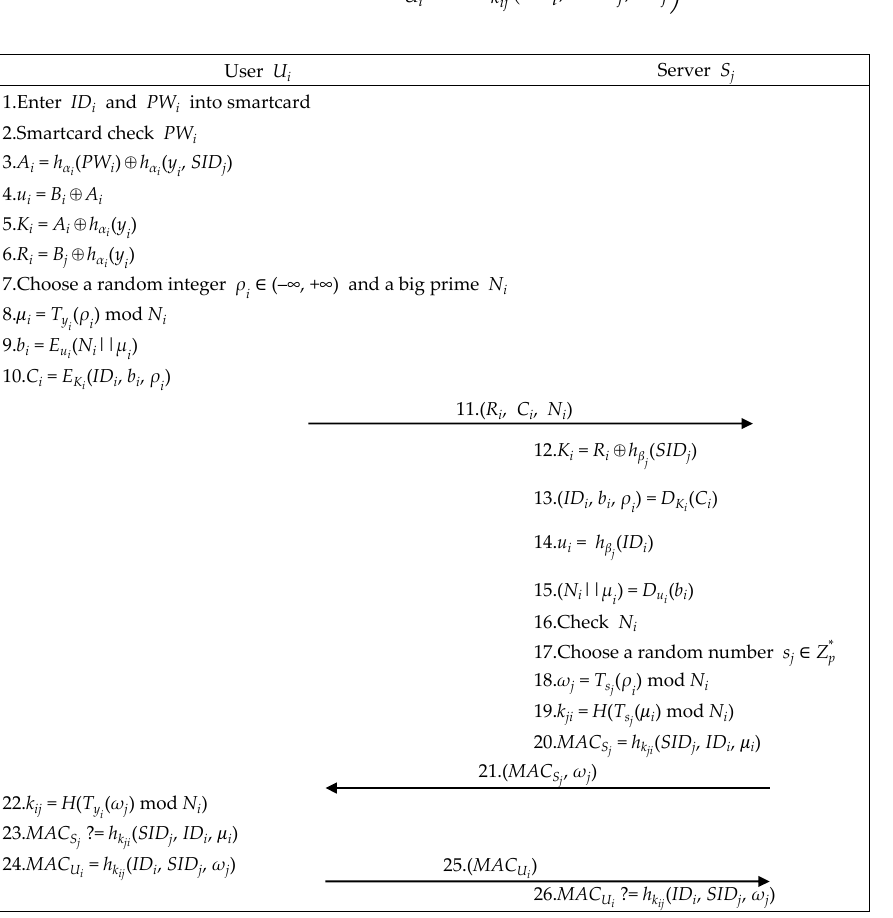
Figure 4. The authenticated key exchange phase of the proposed scheme.